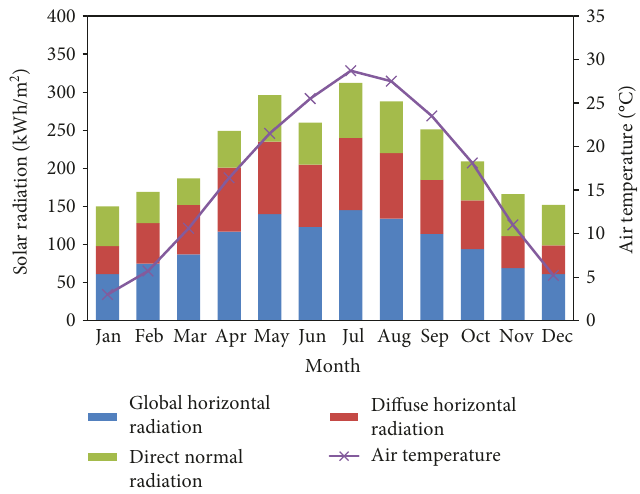
Figure 3: Mean monthly solar radiation and ambient temperature for